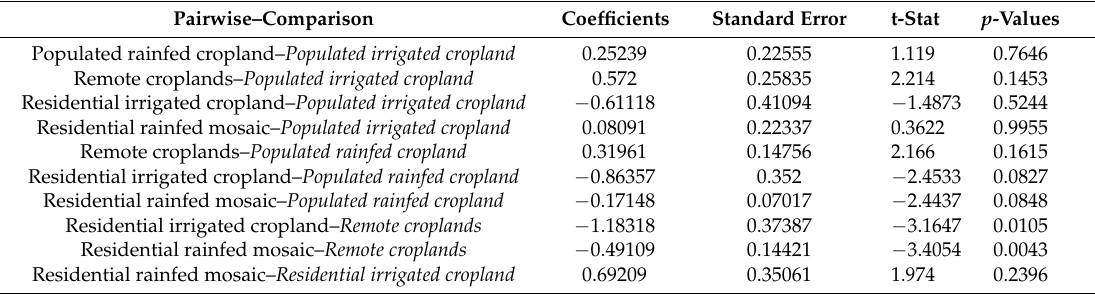
Table 4. Within-anthrome Tukey pairwise comparisons using the negative binomial models with fire count and anthromes croplands categories. Note that the reference variable is in